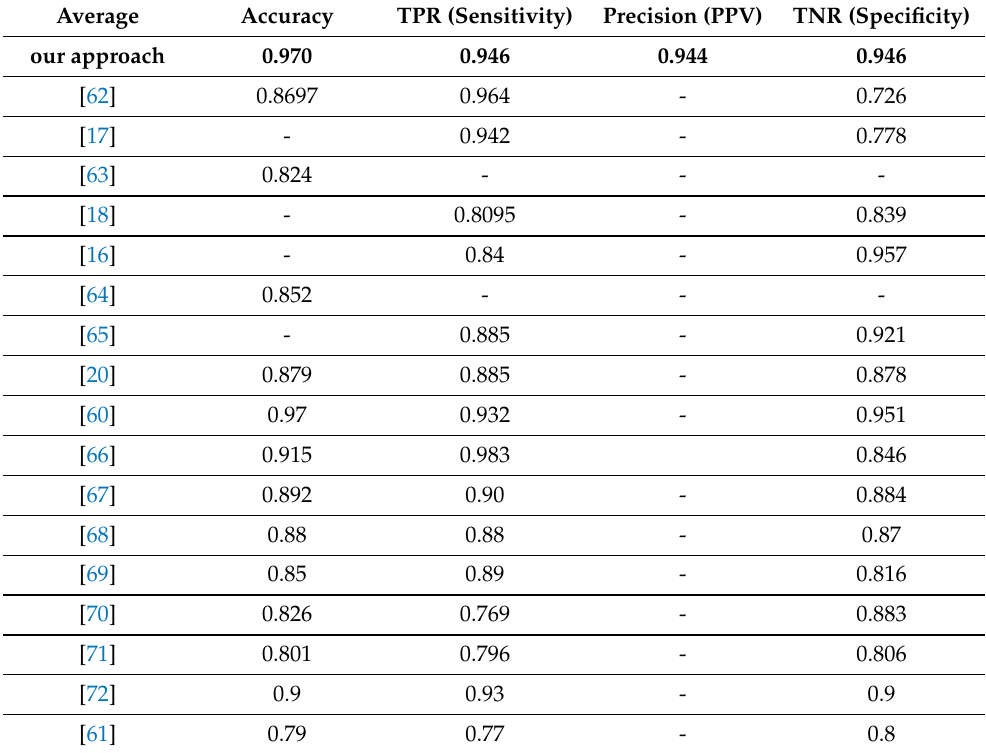
Table 7. Comparative analysis of our method with state-of-the-art methods using whole datasets from PhysioNet